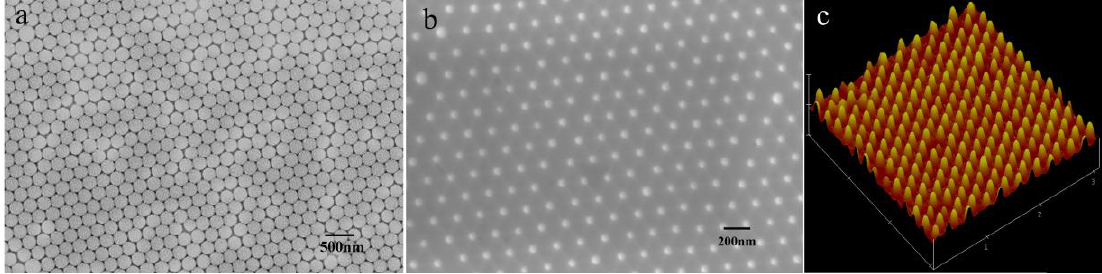
Figure 3. The morphology of the polystyrene (PS) monolayer and Si nanopillar array. ( a ) SEM image of the PS monolayer; ( b ) SEM image of the ordered Si nanopillar array; ( c ) and an atomic force microscope (AFM) image of the ordered Si nanopillar array.